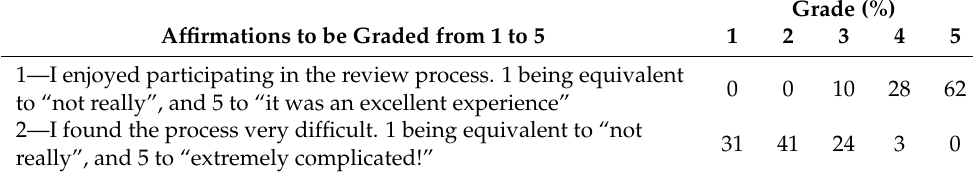
Figure 1. The UALGORITMO is an instrument for outreach activities to layman readers. ( a ) Articles published in peer reviewed journals ( left ) are the raw material for manuscripts submitted to the UALGORITMO ( right ); ( b ) The manuscripts from the authors (scientists), who often use a professional language difficult to understand by laymen, are reviewed for clarification of the text by secondary high school students under the coordination of a schoolteacher.